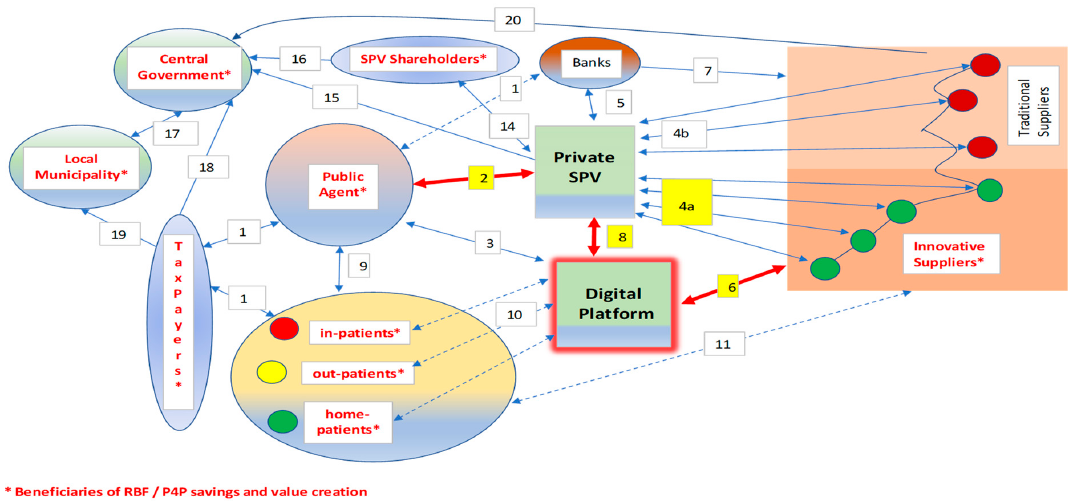
Figure 1. Digital Public-Private Partnership (PPP) management with Pay-for-Performance (P4P)/Results-Based Financing (RBF).